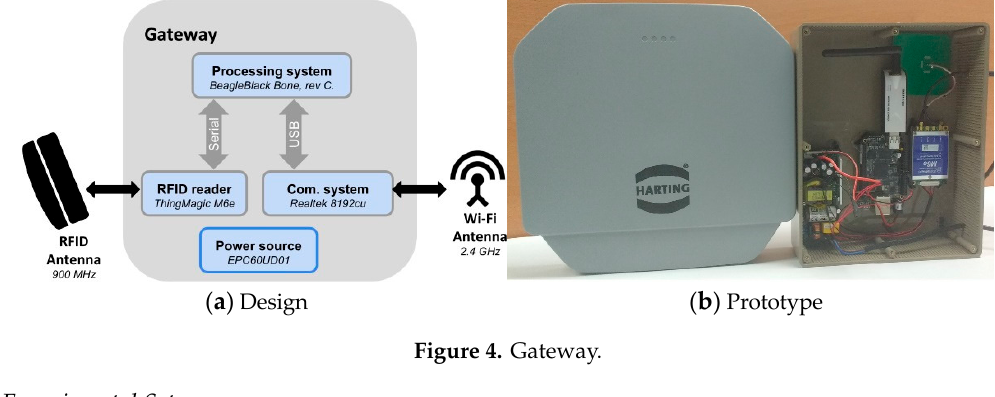
Figure 4. Gateway. Figure 4.